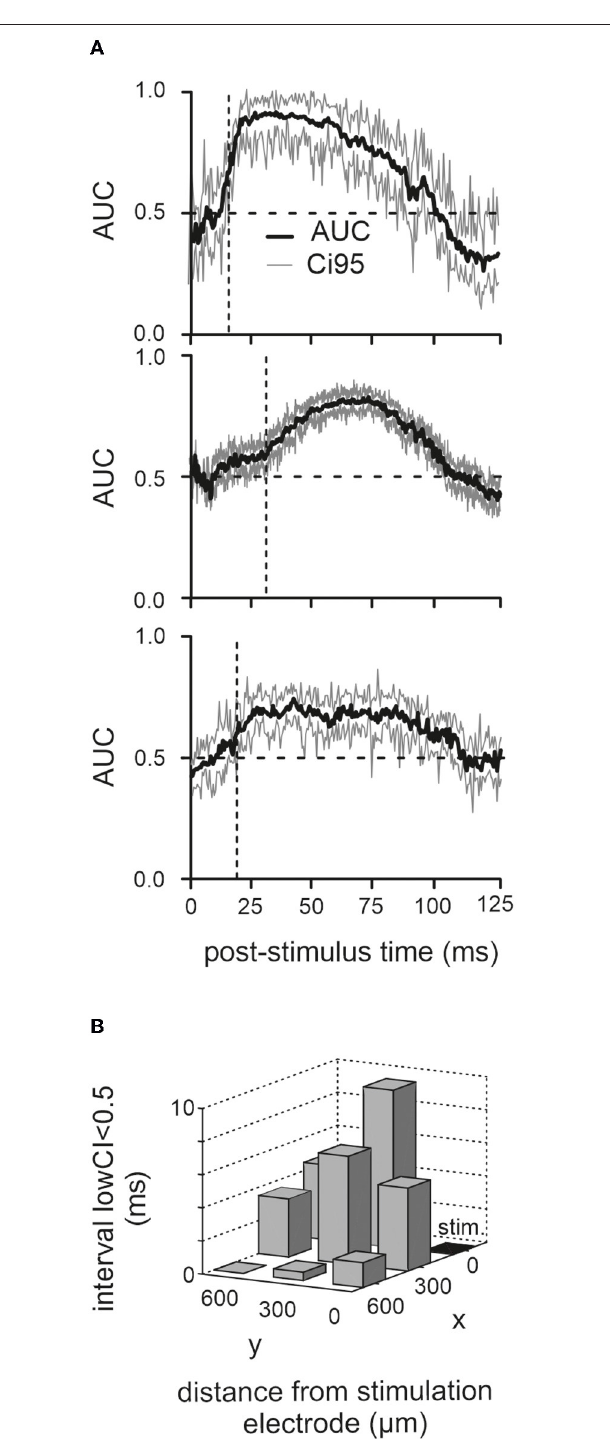
FIGURE 3 | Poststimulus period of nondiscriminability. (A) Corresponding mean and CI95 (1,000 bootstraps) of AUC traces computed from the LFP responses in the three animals (the one with the cut infraorbital nerve is shown on top). (B) Dwell time of lower confidence border below 0.5 (the time from stimulation time to the first occurrence of lower CI > 0.5 is plotted here). Results from recordings from eight electrodes across all three animals are shown. The stimulation electrode (“stim”) is marked